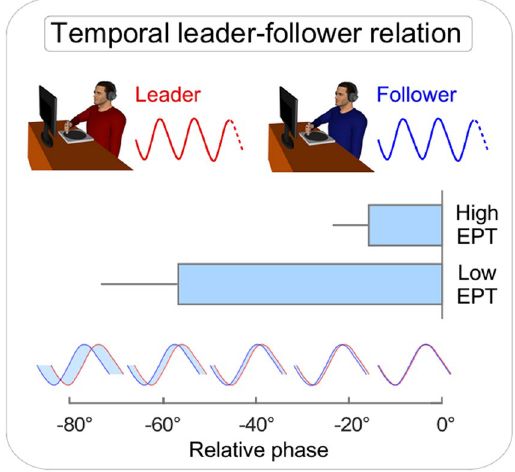
Figure 4. Temporal leader-follower relation. Movement information from both players was codified in terms of phase, indexing the (circular) rotation of the E-music box. Continuous relative phase was computed in order to quantify the extent to which followers’ movements lagged behind leaders’ movements when leadership roles were assigned. Compared to low EPT followers, high EPT followers lagged behind leaders to a smaller degree. Bars represent 1 standard error of the